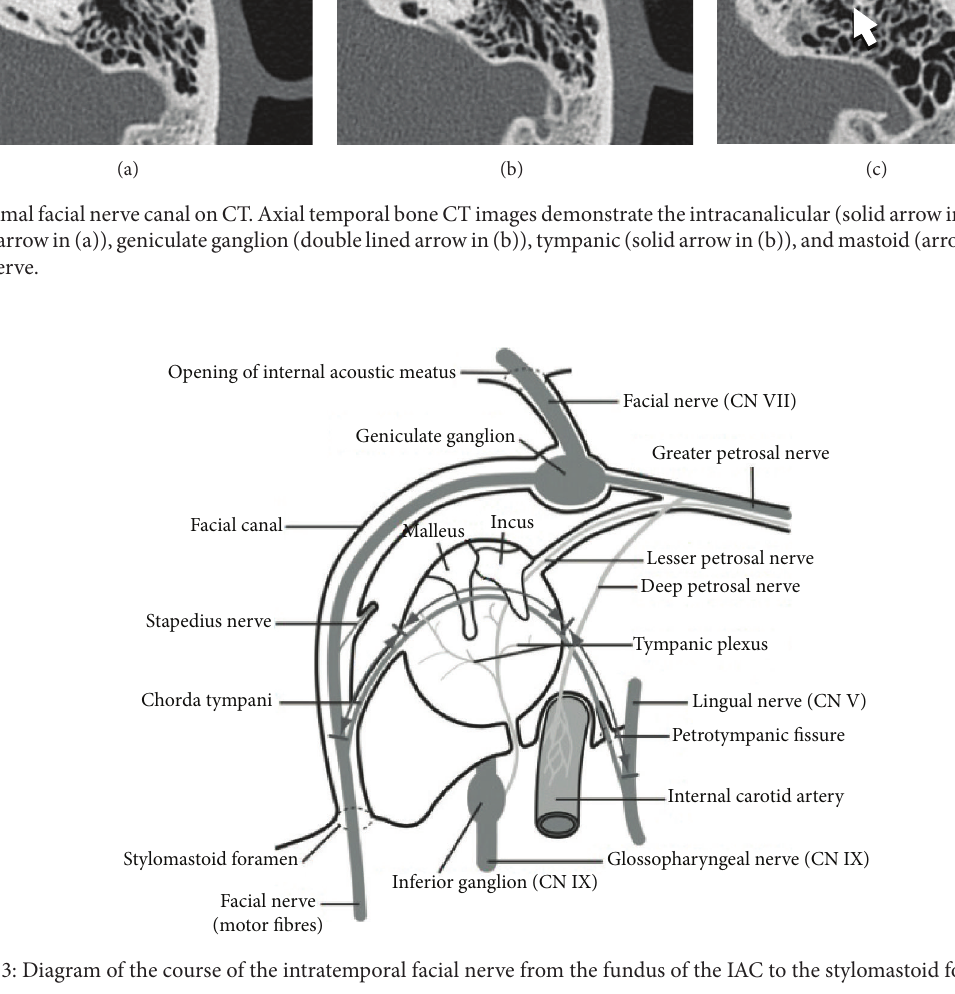
posteriorly to become the tympanic segment (the first or anterior